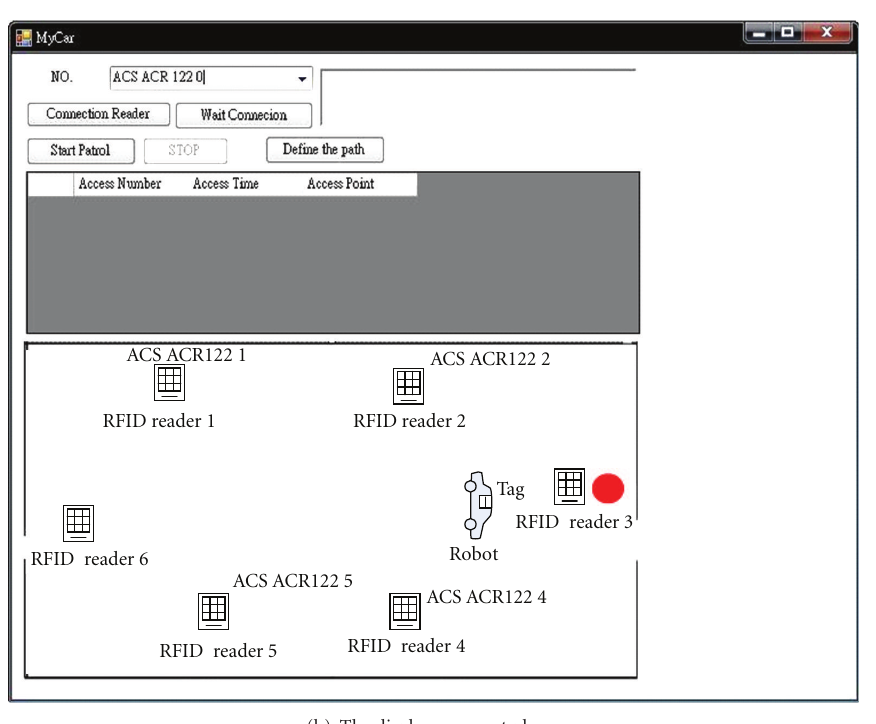
Figure 16: The position of the self-propelled